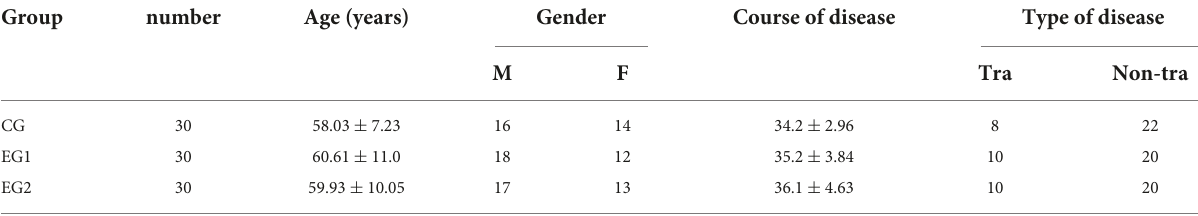
TABLE 1 Comparison of basic conditions of the three groups before treatment.